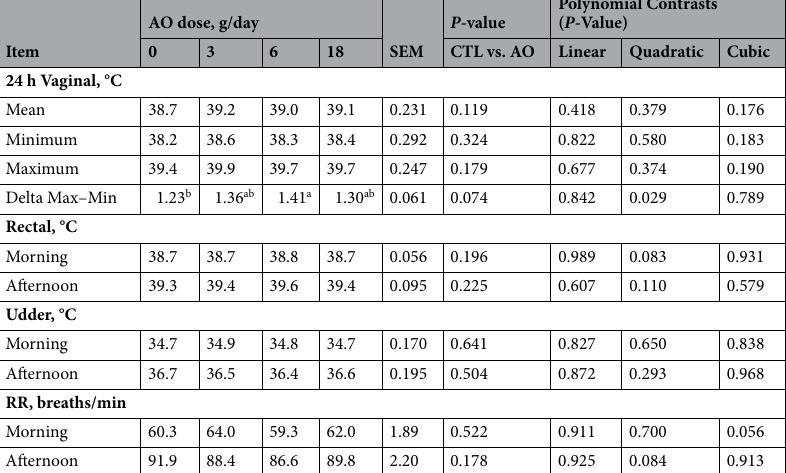
AO dose, g/day 0 CTL vs. AO